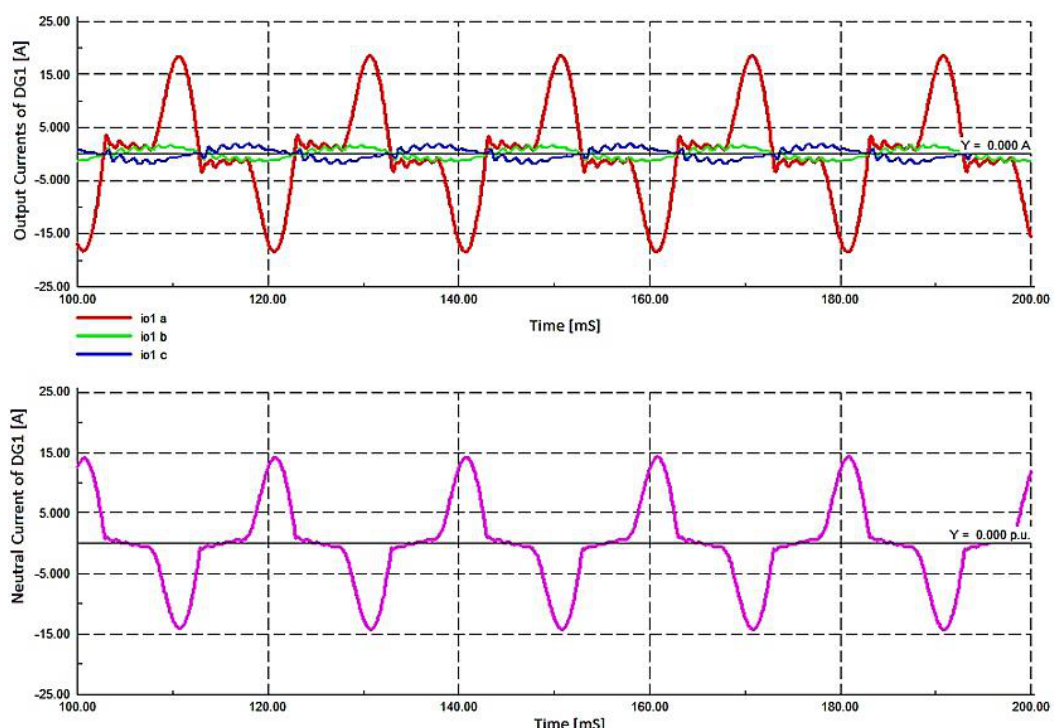
Figure 19. Three-phase output currents and the neutral current of the four-leg inverter.